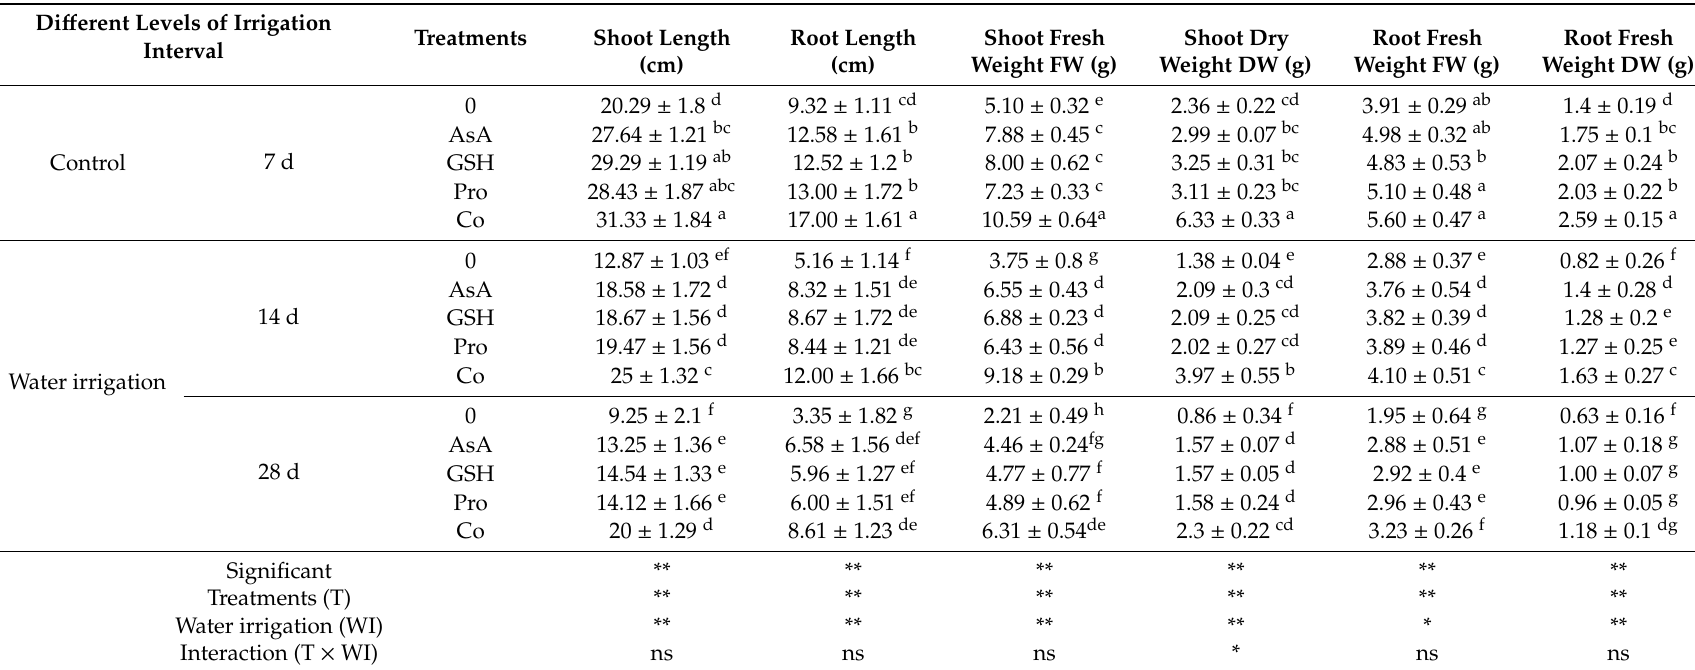
Table 1. E ff ects of ascorbic acid, glutathione and proline on morphological characteristics of chickpea plants under di ff erent irrigation intervals. Di ff erent Levels of